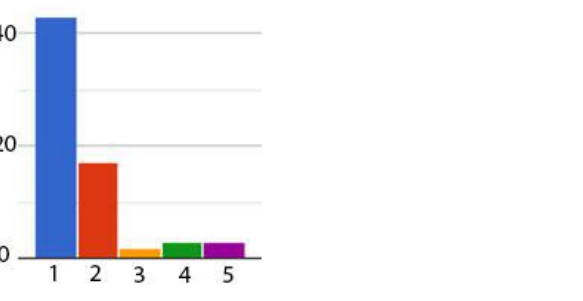
Figure 11. Obtained statistical data for the second question in the initial survey.